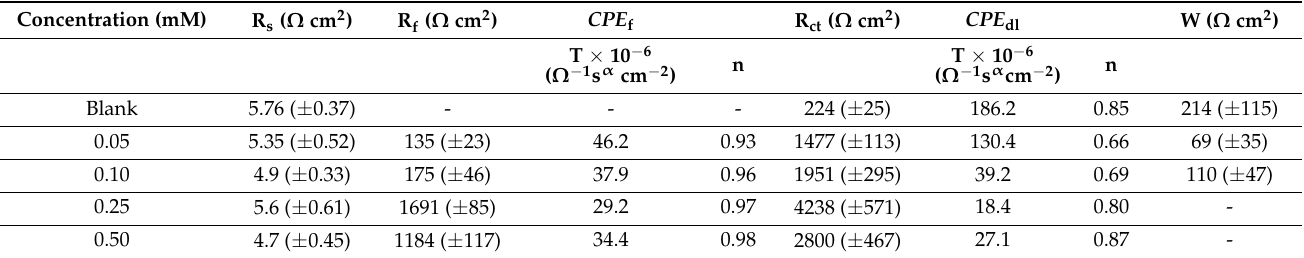
Table 3. Impedance parameters obtained by fitting EIS data using Zview software for the blank and in the presence of different concentrations of corrosion inhibitors.